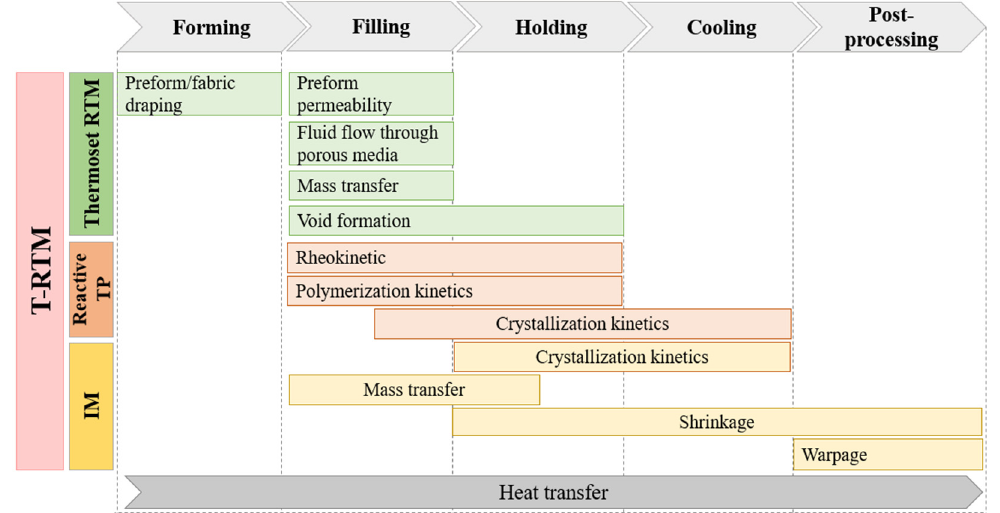
Figure 11. A general concept of T-RTM process simulation as a combination of certain features ofthermosetRTM,reactiveTPprocesses, andIMmodels(RTM—resintransfermolding; TP—thermoplastic; IM—injection molding; T-RTM—thermoplastic resin transfer